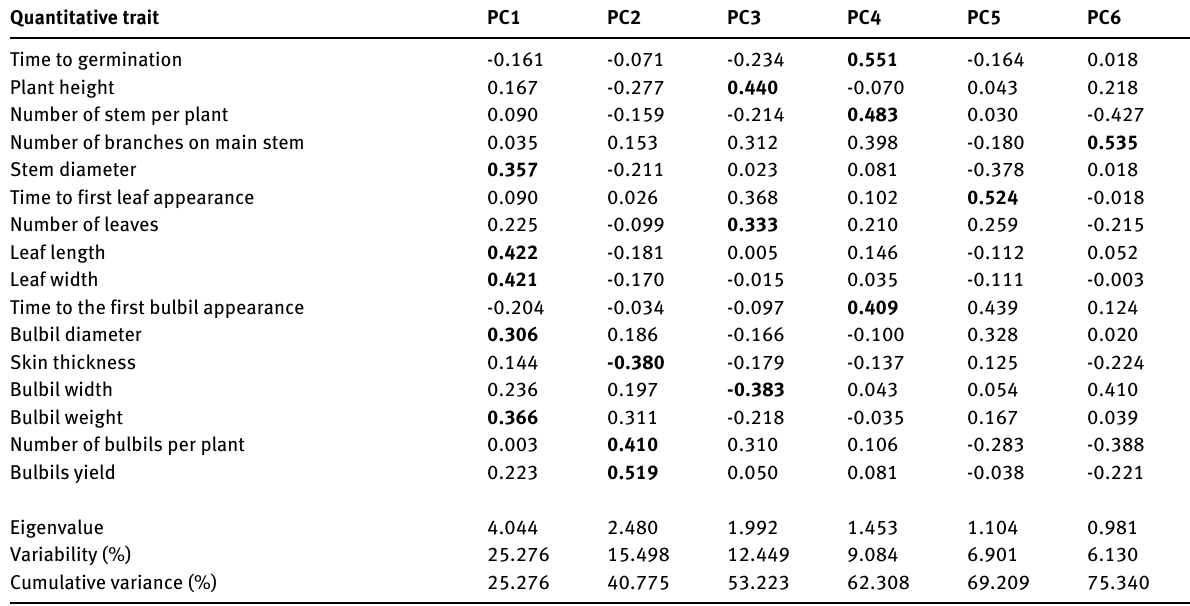
Number of branches on main